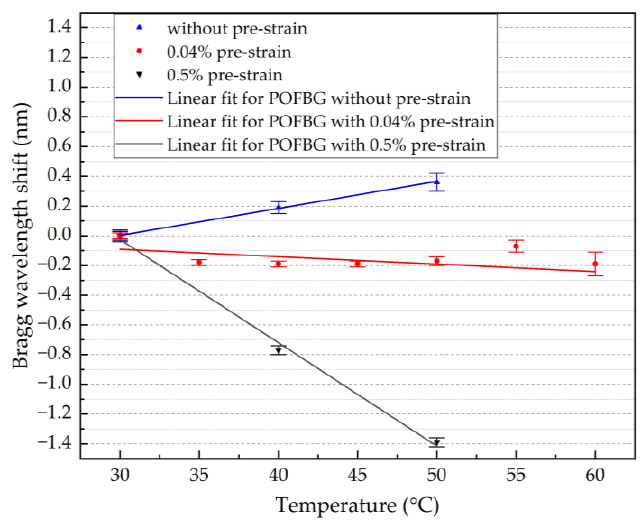
Figure 7. Temperature response of single POFBG under different pre-strain values.